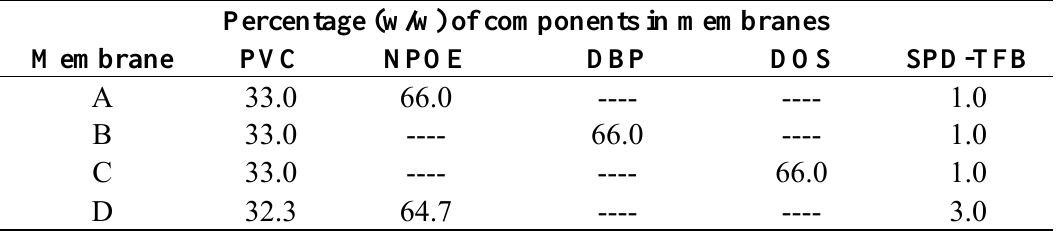
Table 1. Composition of the membranes.